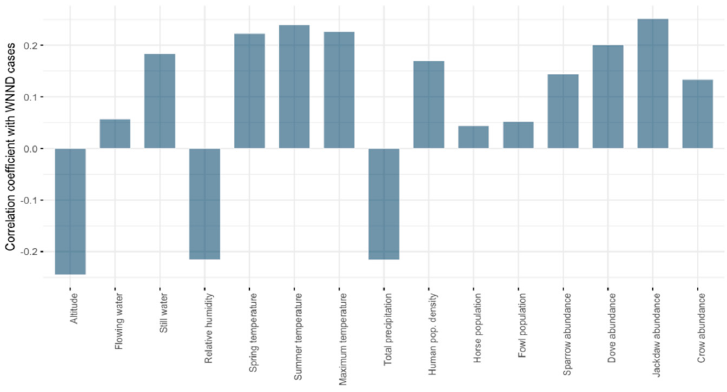
Figure 5. Spearman’s rank correlation coefficient between the number of human WNND cases and the studied predictors for the entire period (2015–2019). Int. J. Environ. Res. Public Health 2020 , 17 , x FOR PEER REVIEW